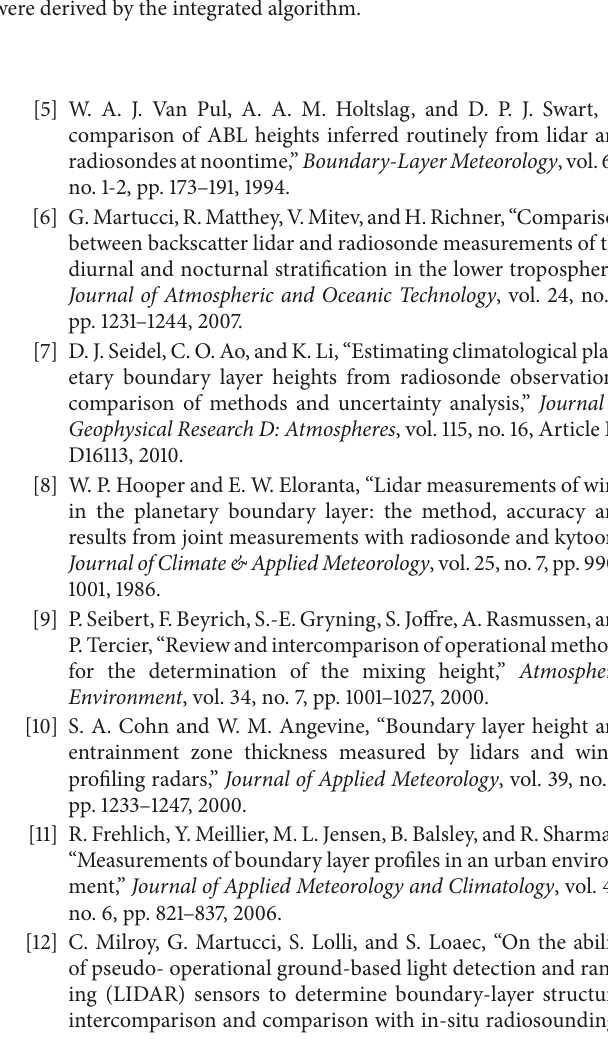
Figure 12: The comparison results of PBLH derived from CALIOP and CE370. (a) The results of PBLH from CALIOP were derived by the maximum variance method. (b) The results of PBLH from CALIOP were derived by the integrated